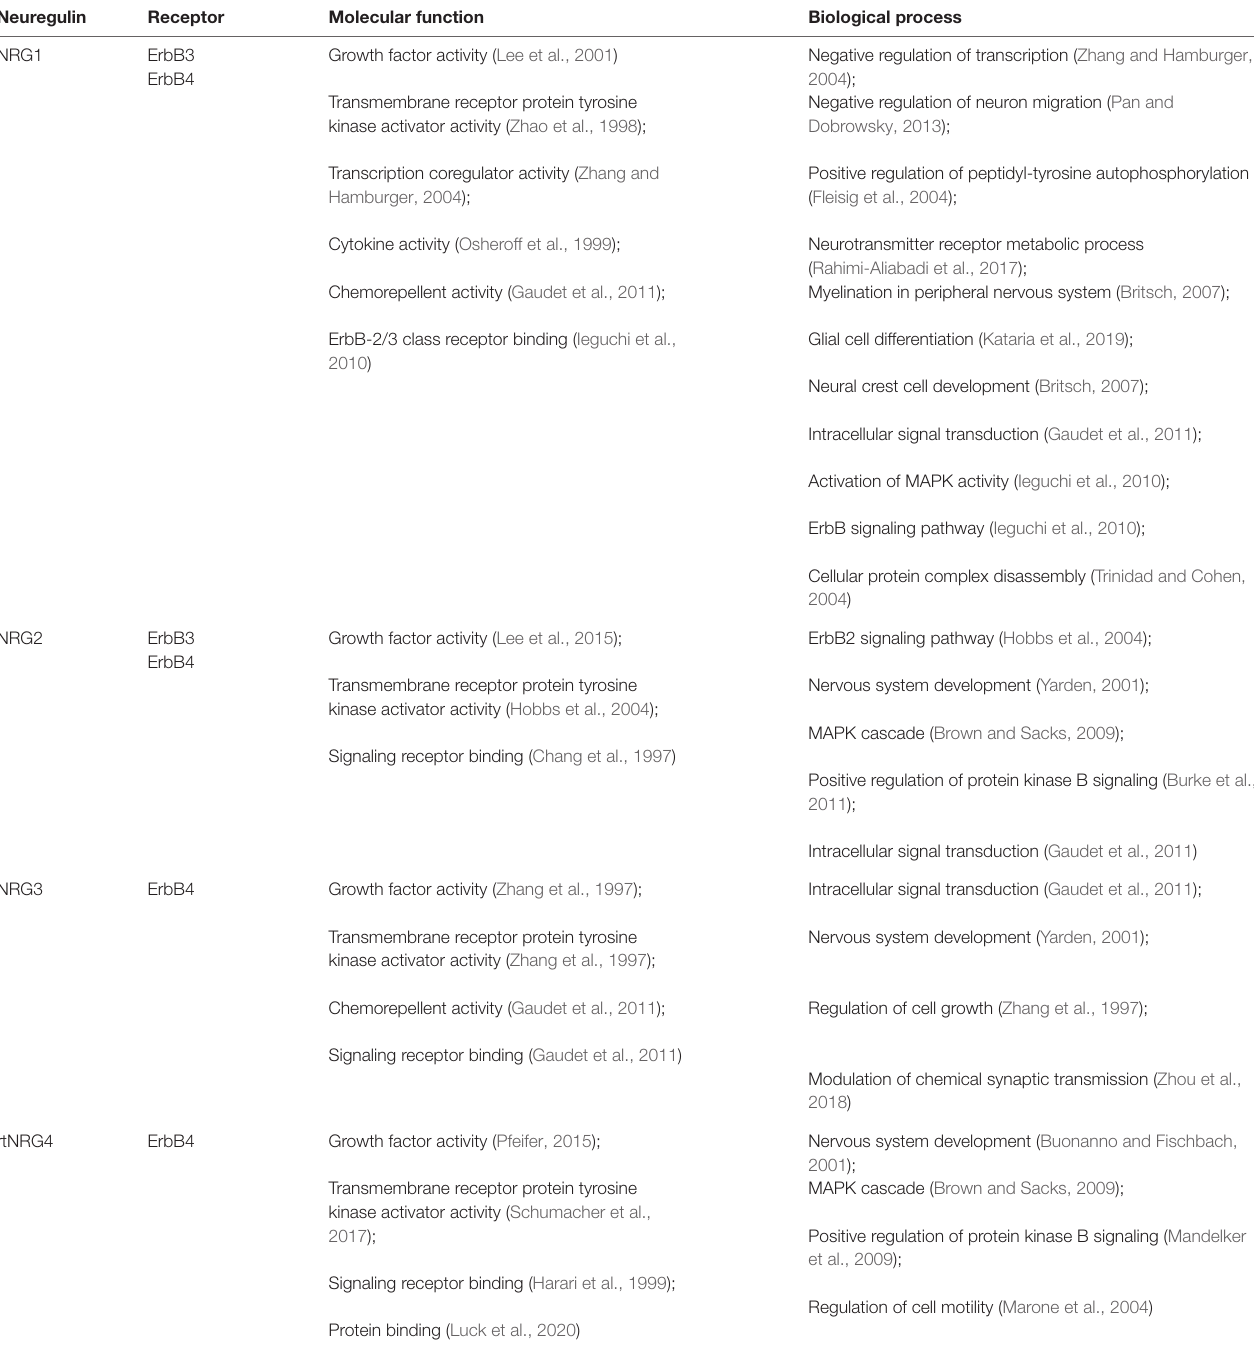
TABLE 1 | Related binding receptors, major molecular function and biological process involved in neuregulins (NRGs).